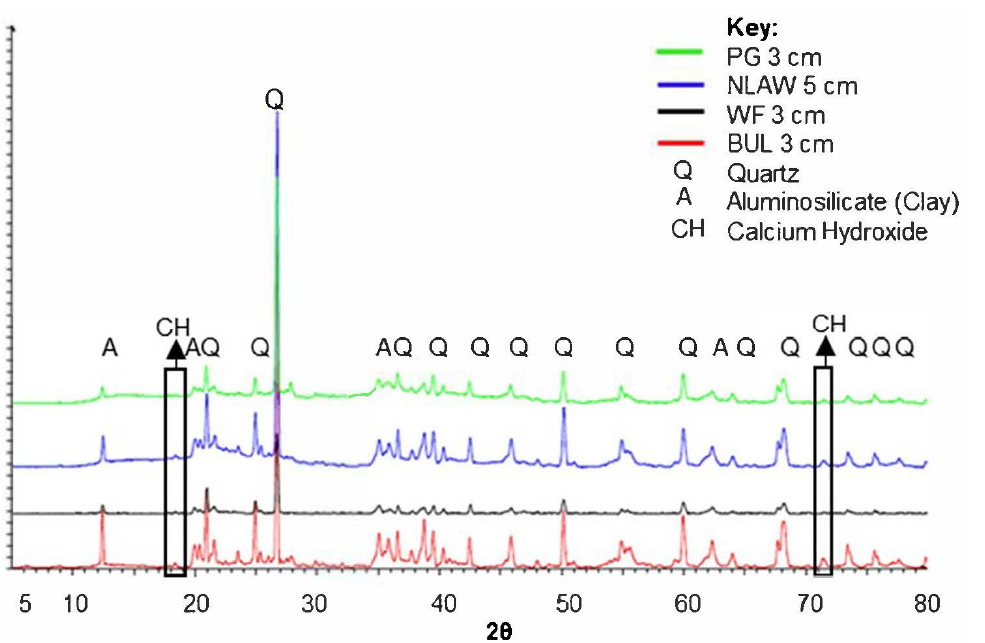
Figure 5. XRD spectra for surface sediment samples (0–5 cm) from urban ( n = 4) Temperate Highland Peat Swamps on Sandstone (THPSS) catchments (from 5–80 degrees 2 θ ). Sites are indicated as Bullaburra (BUL; red), Wentworth Falls (WF; black), North Lawson (NLAW; dark blue) and Popes Glen (PG; light green). The y axis refers to intensity. Quartz is indicated as Q, aluminosilicate as A and calcium hydroxide as CH. Peaks at 18 degrees 2 θ and 71.5 degrees 2 θ are indicative of calcium hydroxide.